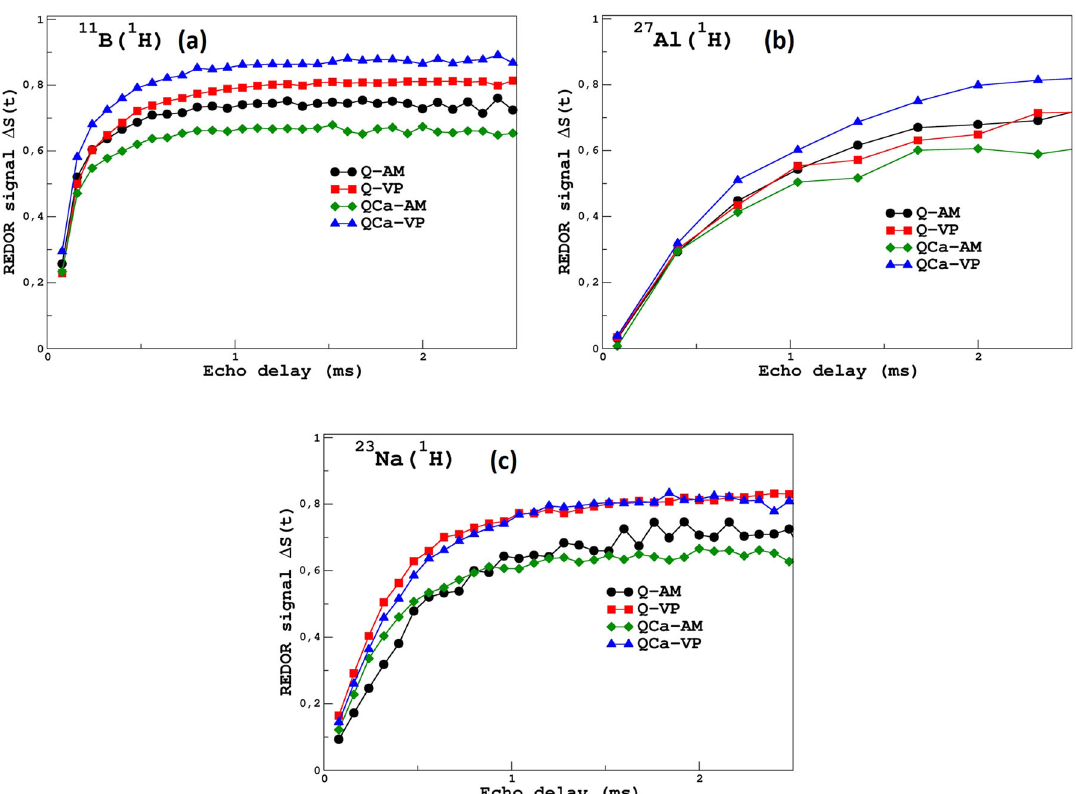
Fig. 8 REDOR NMR. REDOR Δ S(t) curves for the altered glass samples Q-AM, Q-VP, QCa-AM and QCa-VP; a 11 B{ 1 H} REDOR Δ S ( t ) curves; b 27 Al{ 1 H} REDOR Δ S ( t ) curves; c 23 Na{ 1 H} REDOR Δ S ( t )